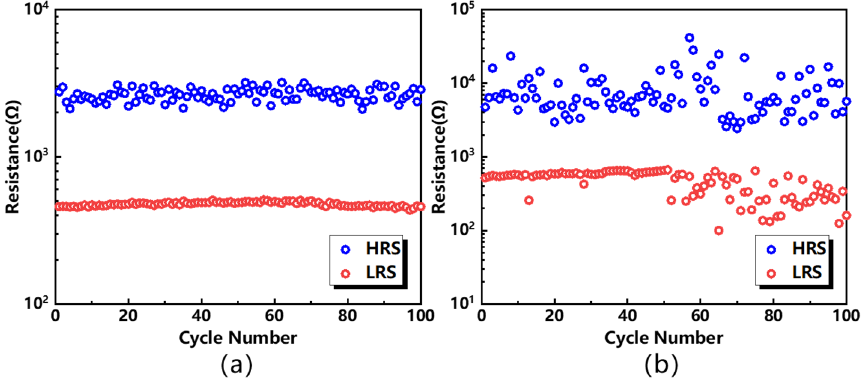
Figure 5. Endurance of HRS and LRS over 100 cycles for ( a ) Pt/TaO x :Al/TiN RRAM and ( b ) Pt/TaO x /TiN RRAM.